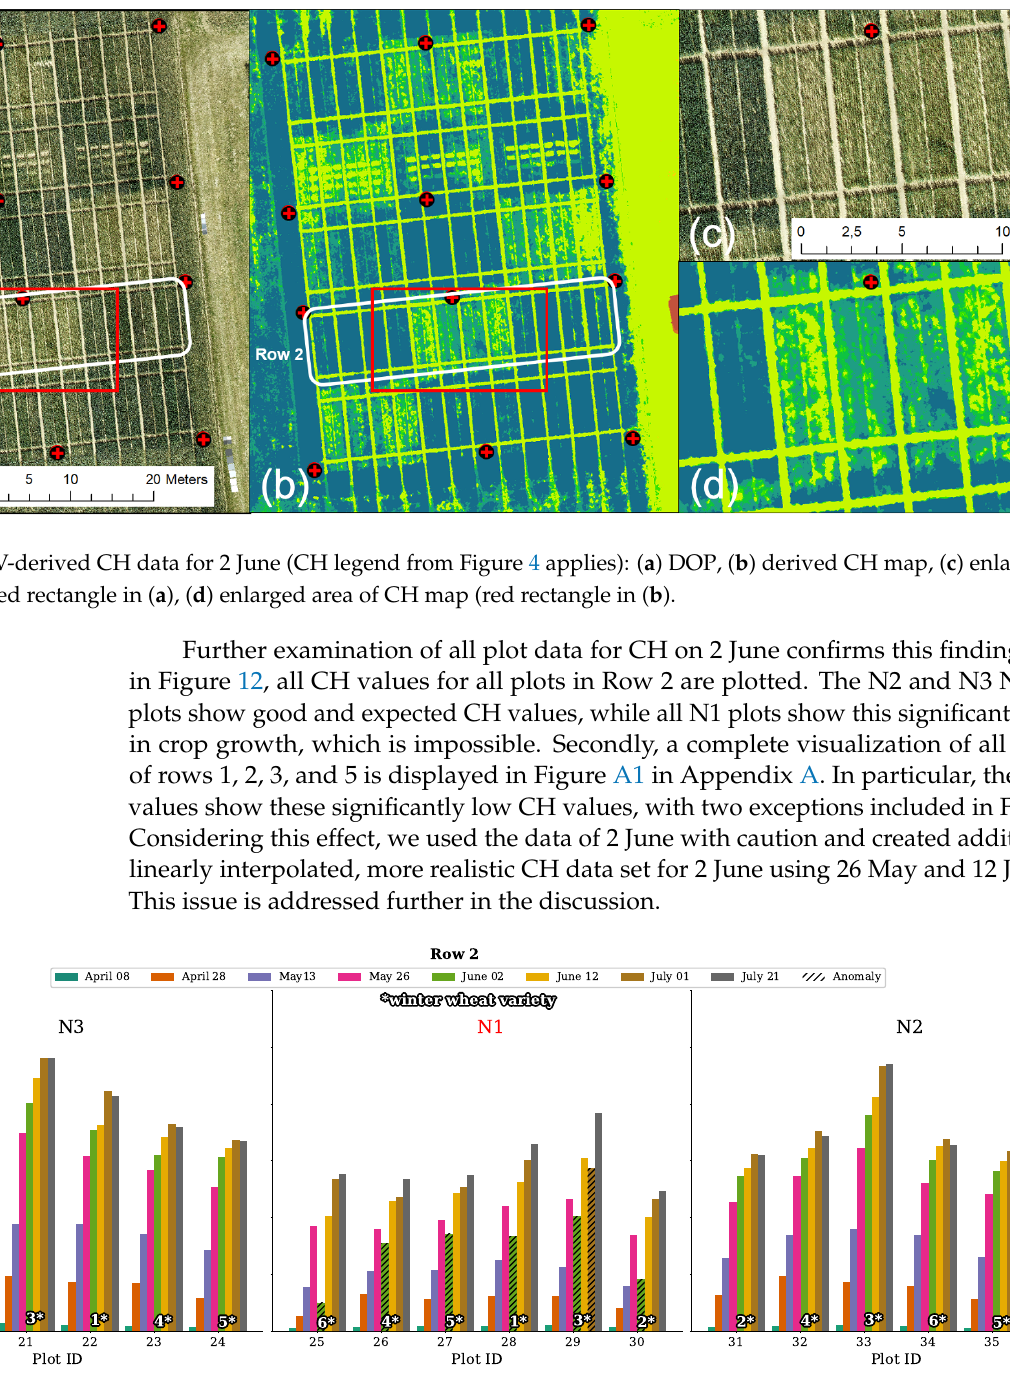
Figure 12. Bar chart representation of CH derived by the UAV for row 2 for all flight dates. For all N1 treatment plots’ varieties, the crop height workflow resulted in an unexpected drop in plant growth for 2 June. This phenomenon is also evident in all N1 stages of the other rows (see Figure A1). Variety no. 3 also shows negative growth for 1 July for all N1 treatments. The corresponding erroneous crop height values are marked with a hatched overlay in